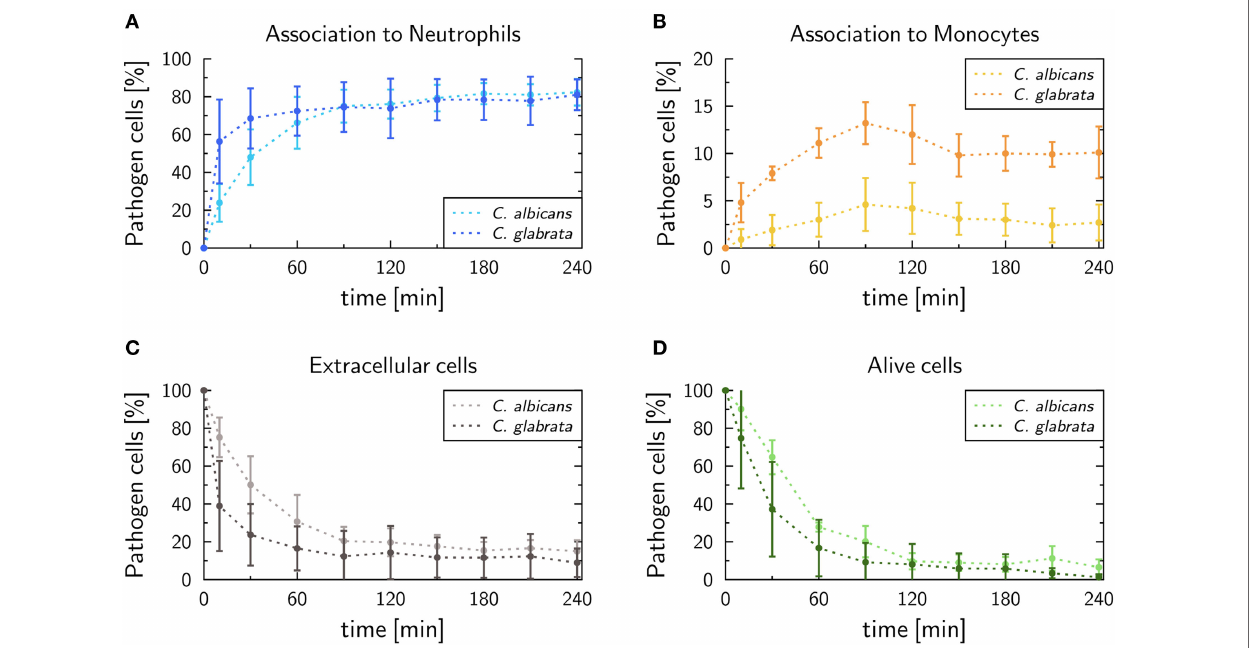
FIGURE 2 | Experimental data of whole-blood infection assays for Candida albicans (light color) and Candida glabrata (dark color), respectively. After incubation populations of extracellular cells (A) , alive cells (B) , as well as pathogens phagocytosed by either neutrophils (C) or monocytes (D) , were measured by flow cytometry and plating